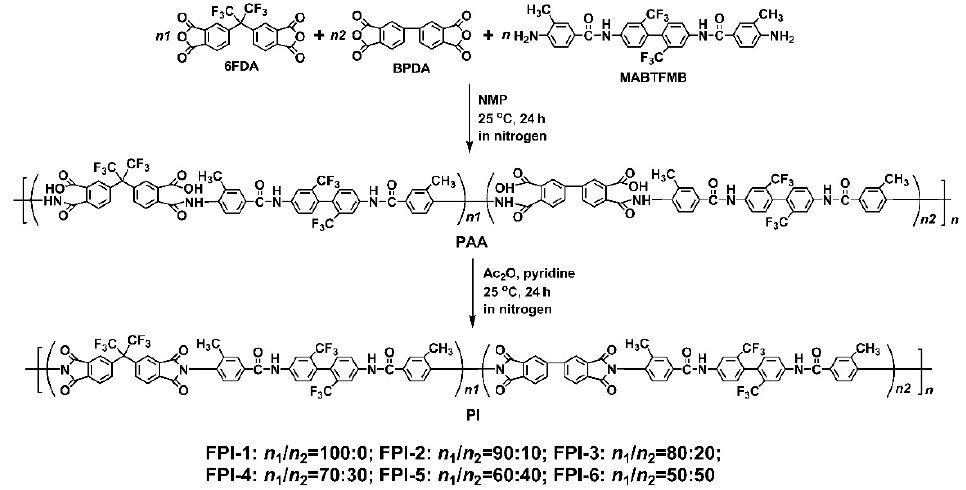
Figure 1. Preparation of organo-soluble FPI resins. Table 2. Molecular weights and solubility of FPI